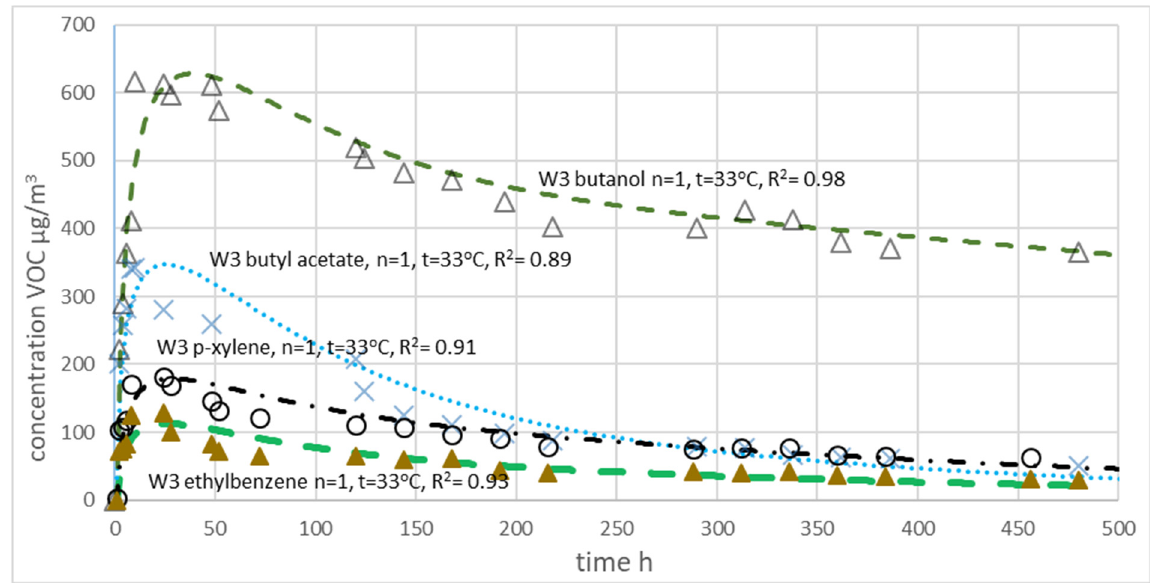
Figure 17. The selected VOC emission profiles from W3 floor systems (testedfor480 h) for the air change rates n =1 h − 1 at 33 °C (and RH=80%) in the test chamber, including butanol, ethylbenzene, butyl acetate and m-p-xylene (W3 sample is a floor system made of: polyurethane solvent primer, polymer–cement waterproofing (2) and Epoxy adhesive).